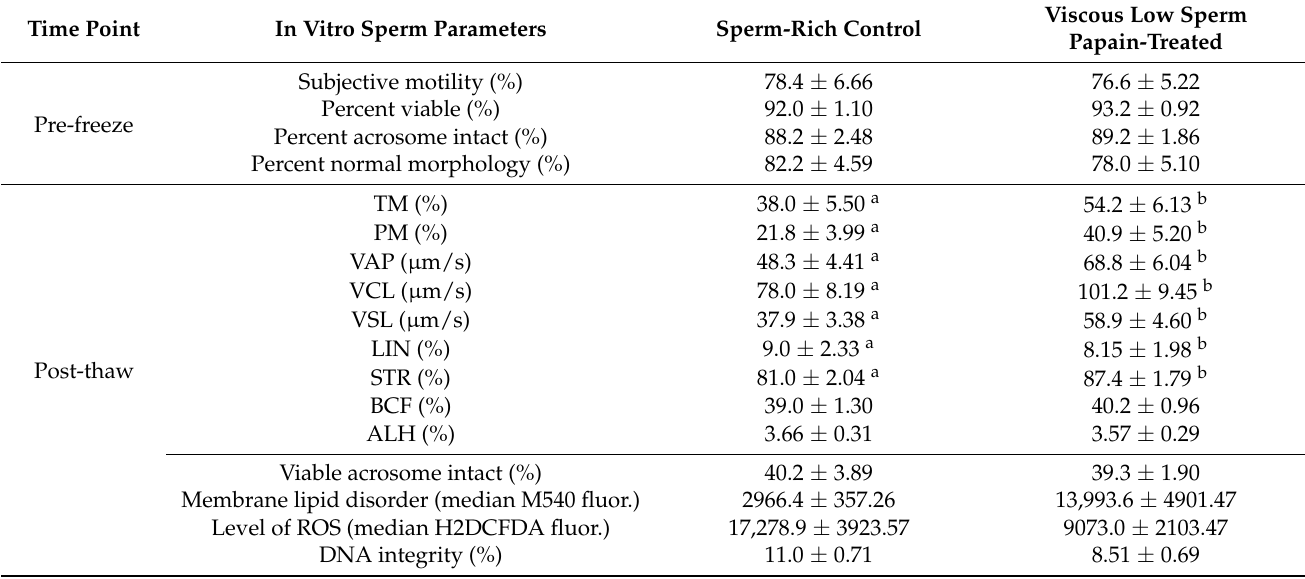
Table 3. Pre-freeze and post-thaw characteristics of sperm-rich and viscous low sperm papain- treated spermatozoa collected from southern white rhinoceros bulls (n = 6) following treatment, centrifugation and dilution in ButoCrio (Exp 2). Data is pooled over bull and time (0, 1.5 and 3 h post-thaw) ± SEM. Columns which differ in superscript indicate significant differences between sperm-rich control and papain-treated spermatozoa ( p <